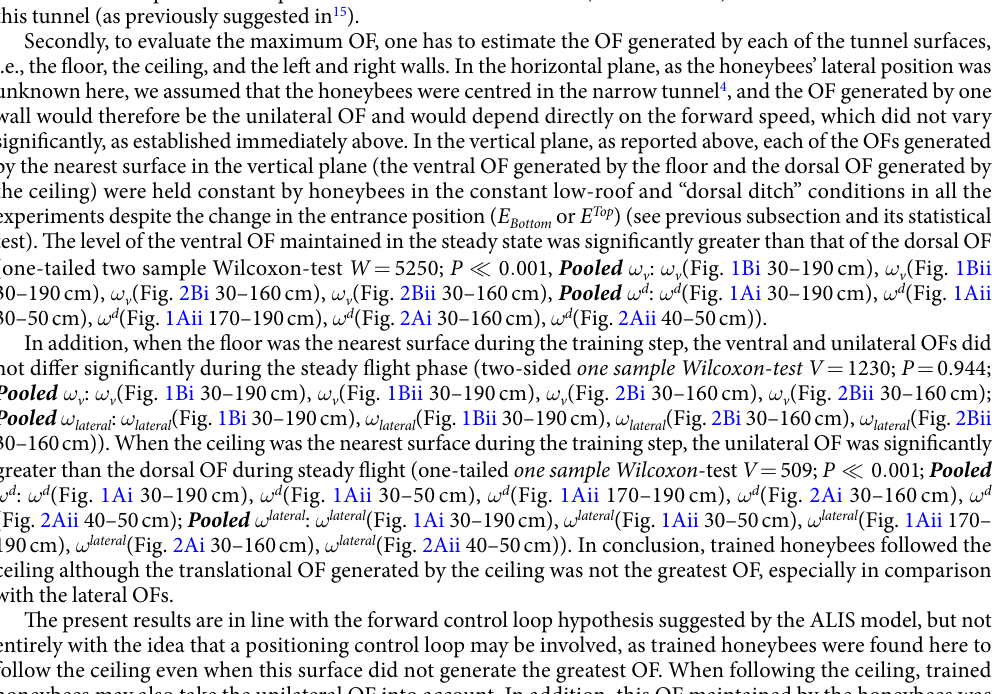
x (Fig. 1Ai 30–190 cm), v x (Fig. 1Bi 30–190 cm), v x (Fig. 1Bii 30–190 cm), v x (Fig. 2Ai 30–160 cm), v x (Fig. 2Bi 30–160 cm), v x (Fig. 2Bii 30–160 cm); anova . lme : F 1/34 = 2.3976, P = 0.1308). The ground speed therefore can be said to have been similar in all these tunnels and experiments: this state-